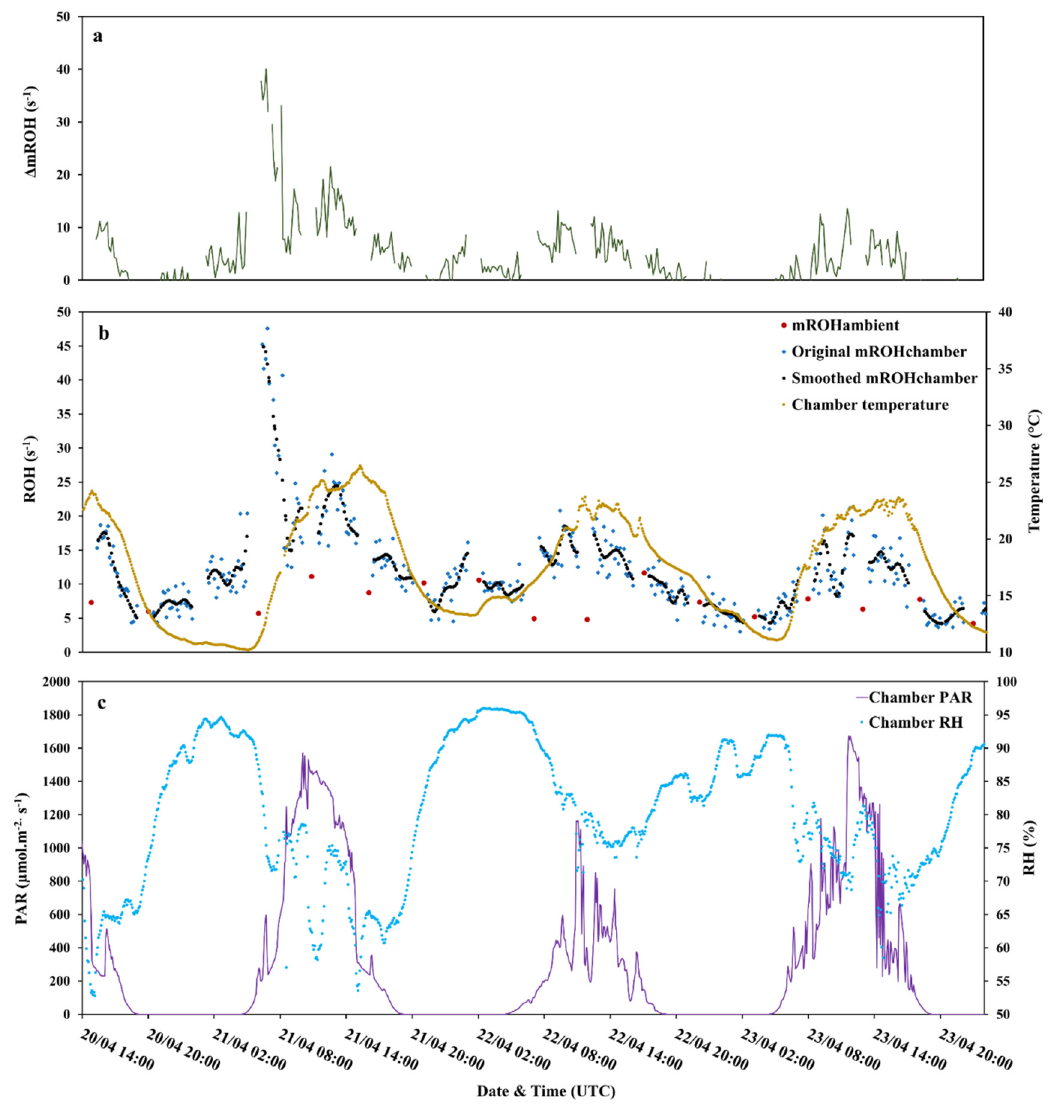
Figure 3. Variability of ( a ) ∆ mROH = mROH chamber − mROH ambient and ( b ) total mROH chamber (blue dots represent the original OH reactivity data and black dots represent the trend obtained after smoothing the original data) and total mROH ambient (red dots) from the 20th to the 23rd April 2017 with temperature (T ( ◦ C), yellow), ( c ) photosynthetic active radiation (PAR µ mol m − 2 s − 1 , purple) and relative humidity (RH%, light blue), all three parameters measured inside the chamber.